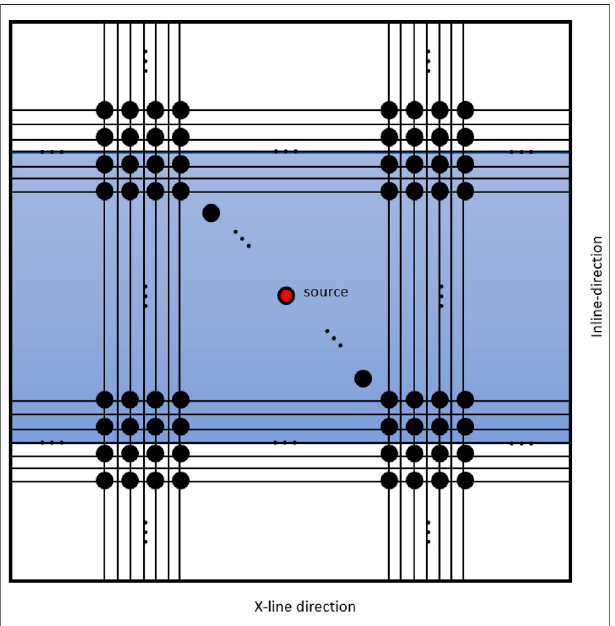
FIGURE 7 | Schematic sketch of the acquisition geometry. Black dots are sources. Blue box shows receivers corresponding to red dot (source).